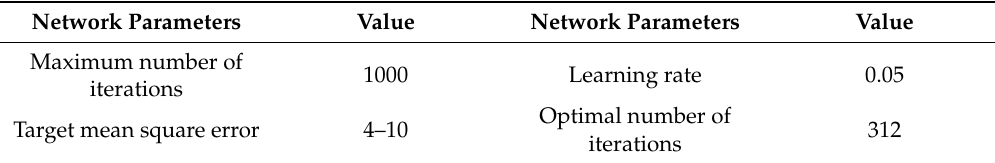
Table 1. Key parameters of the network